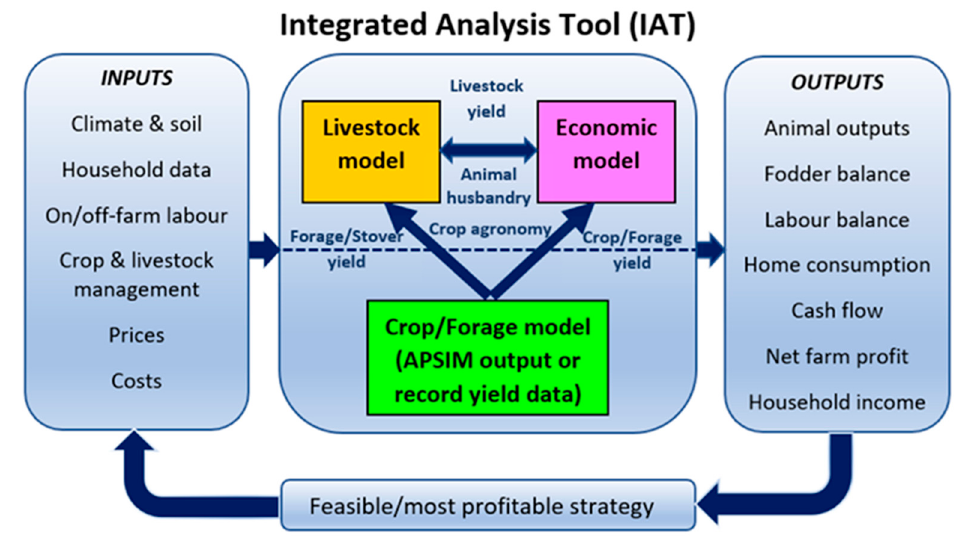
Figure A1. Framework of the Integrated Analysis Tool (IAT) (Source: adapted from [56]).